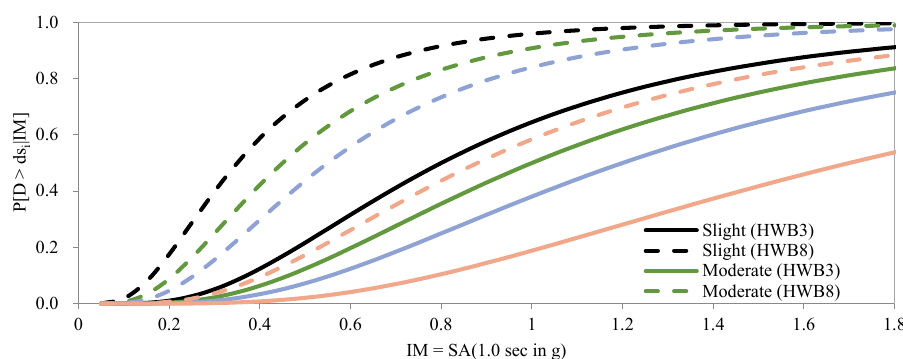
probability. Figure 9. Scenario 1 overall damage state. Figure 9. Scenario 1 overall damage state.